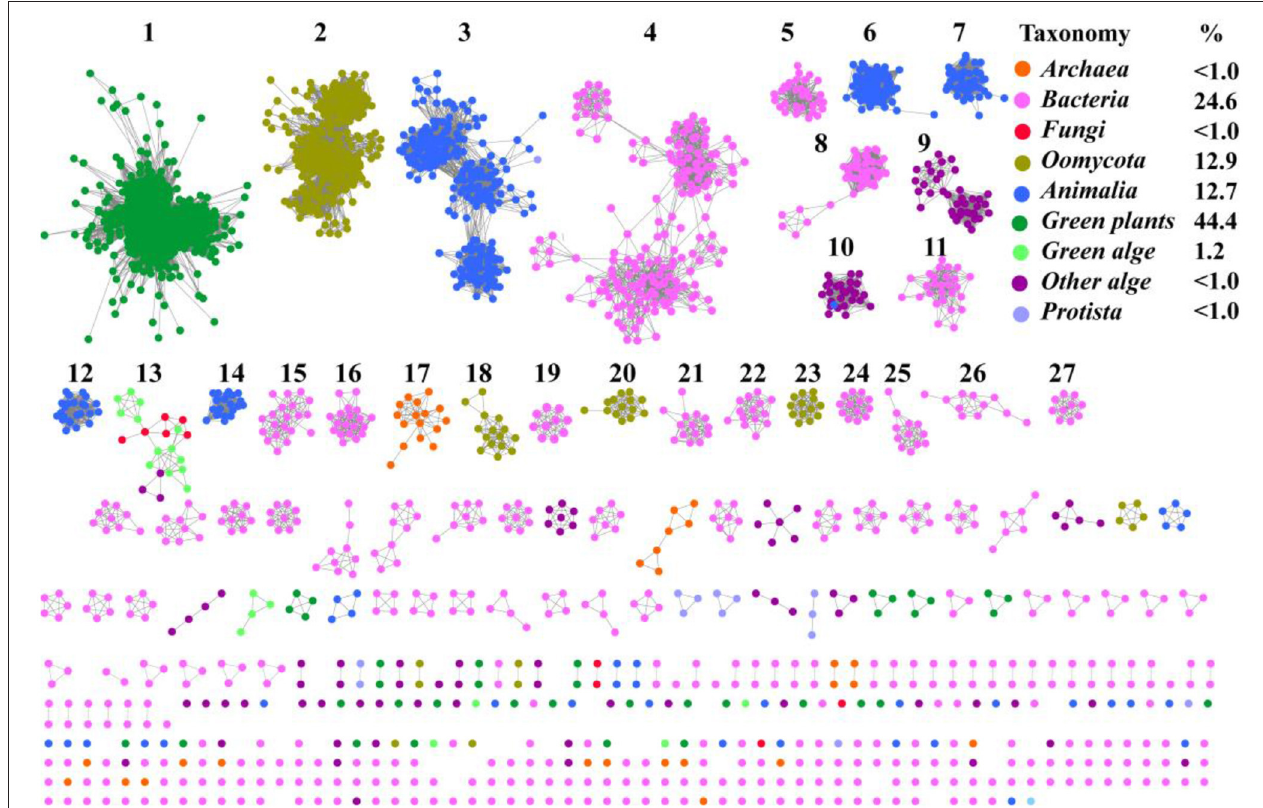
FIGURE 1 | Taxonomic distribution of SWEETs and SemiSWEETs. The proteins listed in S1 Dataset were used to generate the network, using an e-value of 10 − 55 ( > 50% sequence identity). Each node represents one protein. Edges are shown with e-values below the indicated cutoff. Clusters containing more than 10 nodes are labeled sequentially. Nodes from the same taxonomic groups in the global network are the same color. The colors corresponding to different taxonomic groups are listed on the right. Taxonomic classifications included were the class Oomycota; the phyla Streptophyta (green plants), Chlorophyta (green algae), and other algae; the kingdoms, Metazoa, Fungi, and Protista; and the superkingdoms Bacteria and Archaea. The colors corresponding to the different taxonomic groups and the percentage of proteins in each group are listed on the right.